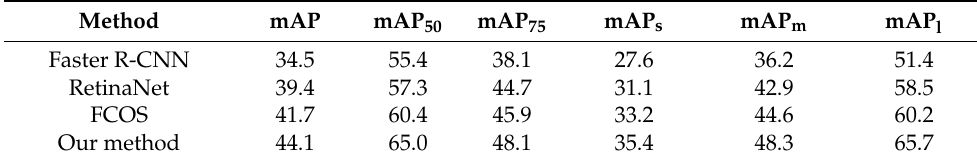
Table 2. The comparisons of numerous detection methods.